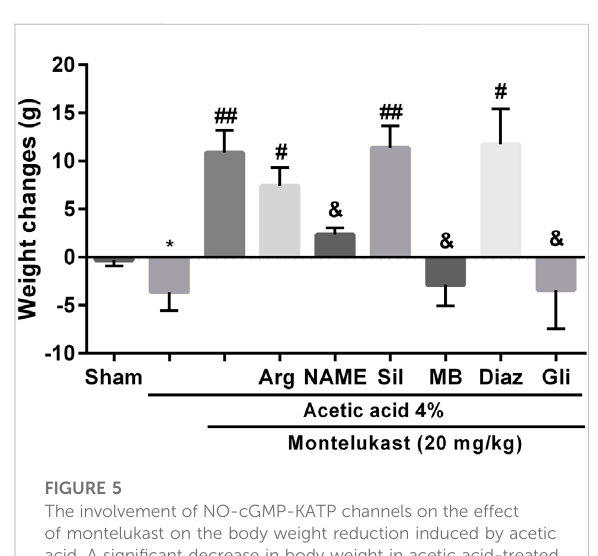
FIGURE 5 The involvement of NO-cGMP-KATP channels on the effect of montelukast on the body weight reduction induced by acetic acid. A signi fi cant decrease in body weight in acetic acid-treated rats was observed. * p < 0.01, when compared to the Sham group; ## p < 0.05 when compared to the acetic acid group; & p < 0.05, when compared to the Mon-treated group. The statistical analysis was performed by ANOVA followed by Tukey ’ s post hoc